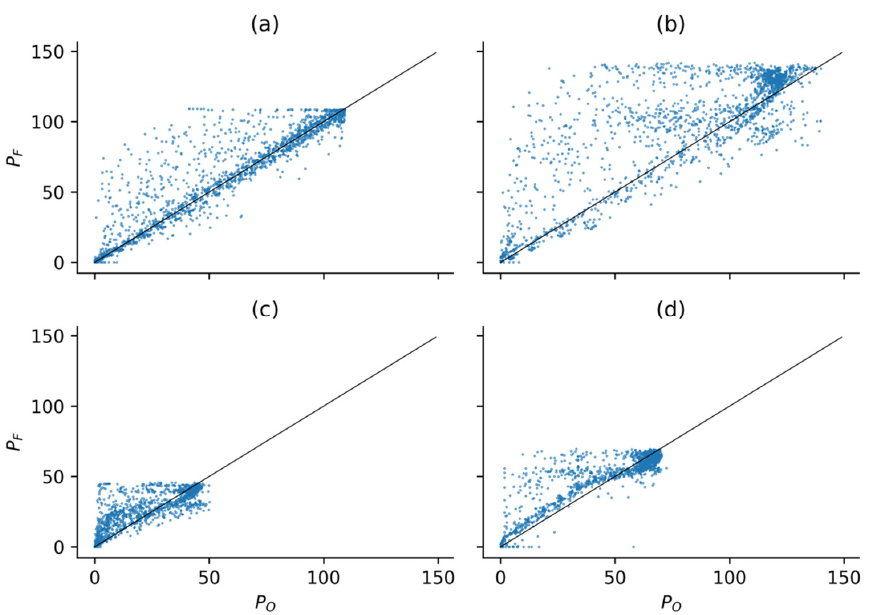
Figure 8. Forecasted power (ensemble mean) at 5 min compared to observed power in the benchmarking period for: ( a ) QLD-A; ( b ) QLD-B; ( c ) VIC-A; ( d ) QLD-C. The reference line y = x is shown in black. Table 7. Error metrics for predicted mean power ensemble at advection of 5 min.